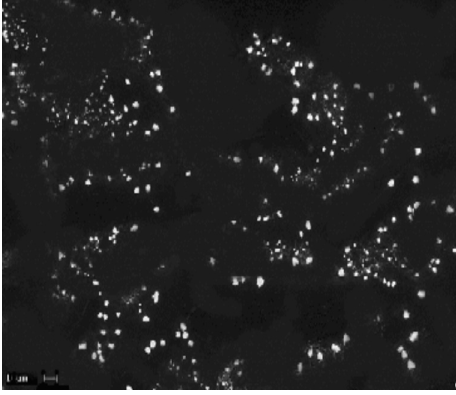
FIGURE 1 - SEM picture of LTZ-PLGA-NPs (40% LTZ).